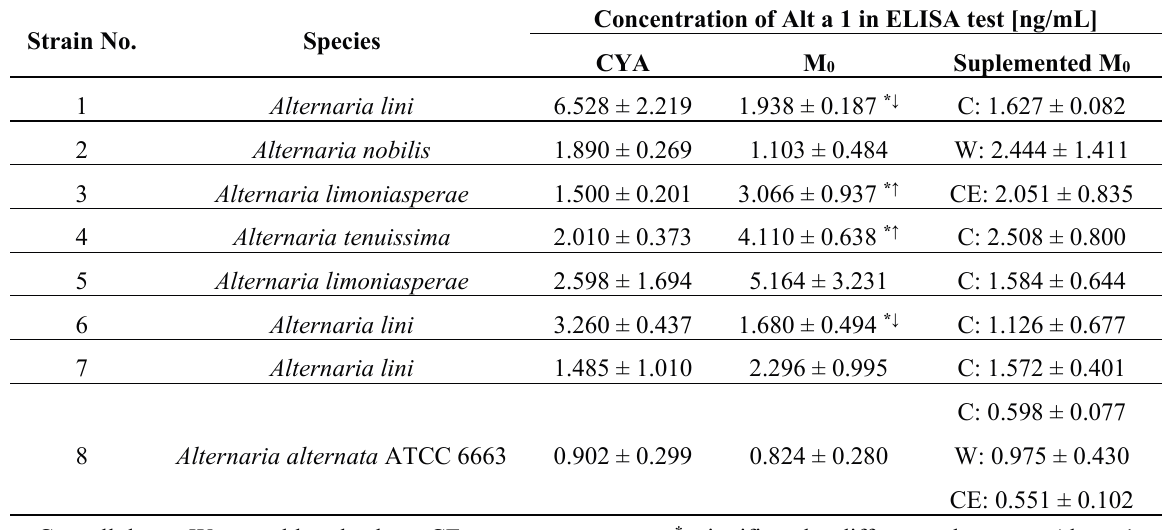
Table 7. Production Alt a 1 allergenic protein by tested Alternaria strains. Strain